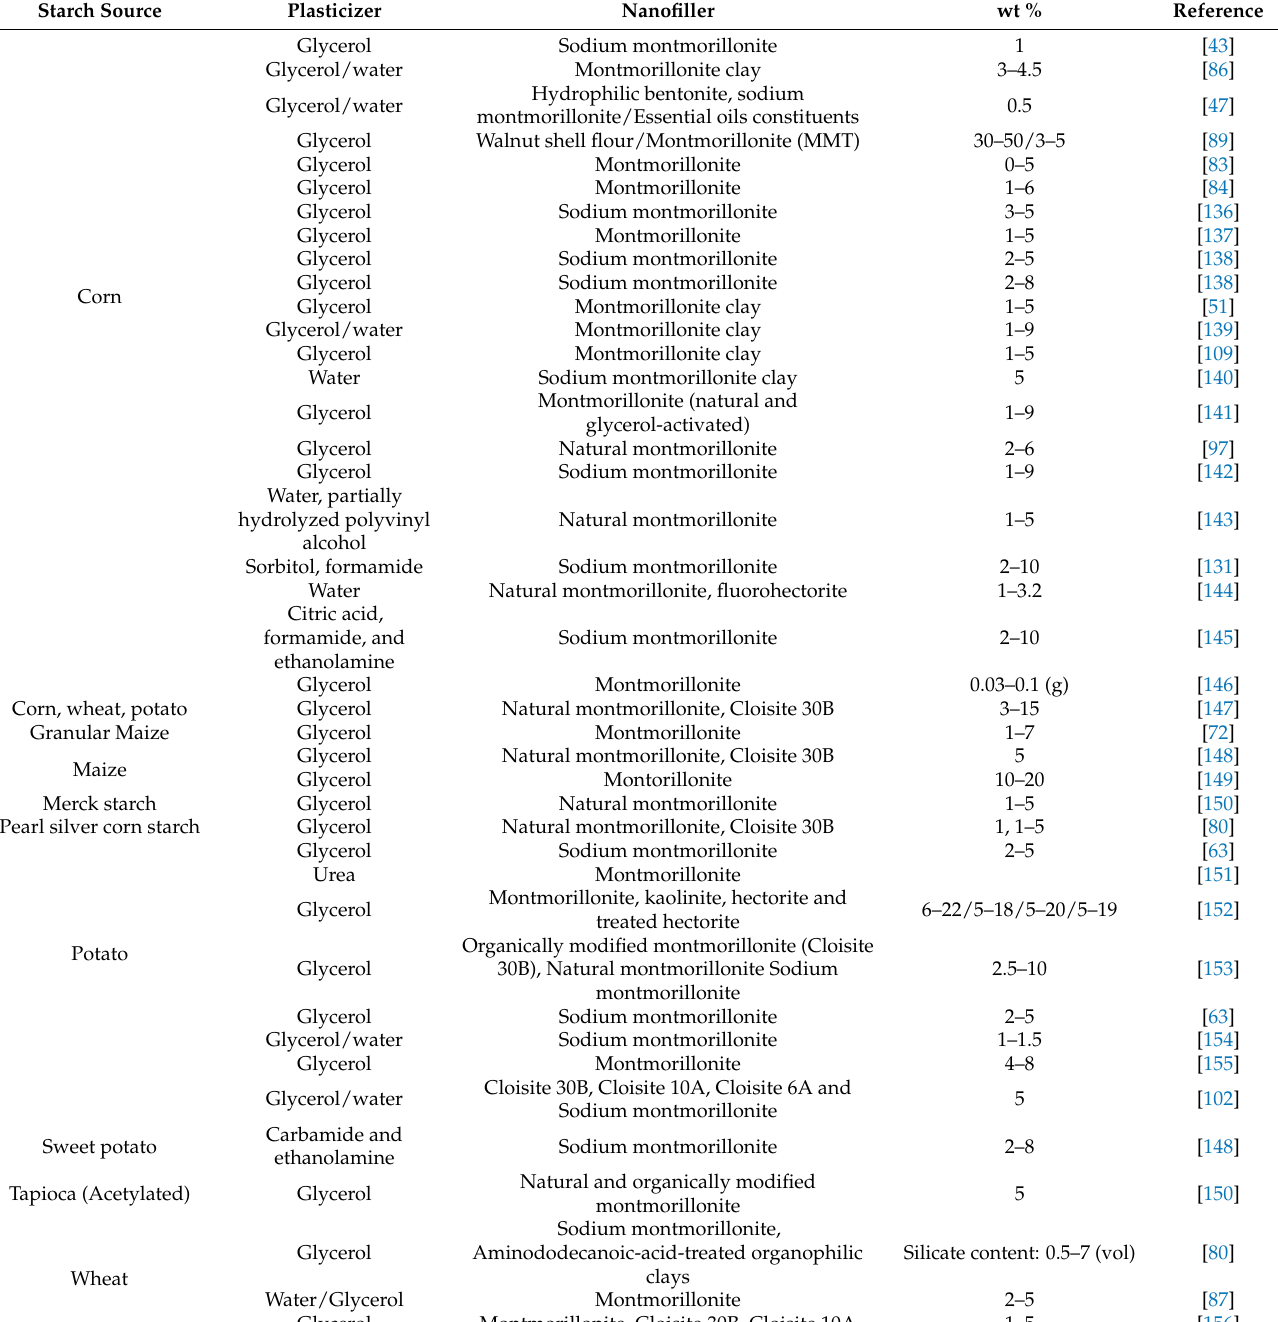
Figure 20 represents the elastic modulus, strength, and elongation to break concerning the MMT content, which is the most used nanofiller in the TPS matrix due to the high performance obtained. In the case of elastic modulus and strength (Figure 20a,b, respec- tively), they increase with the MMT content, and the dispersion cloud is higher between 2 and 6 wt % of MMT. However, the decrease in elongation (Figure 20c) does not follow a trend in its scattering. The behavior in the range (2 to 6 wt %) is due to the dispersion and distribution of the filler being adequate to improve the properties of the polymer. When the content is higher, agglomerates can be produced, decreasing the mechanical